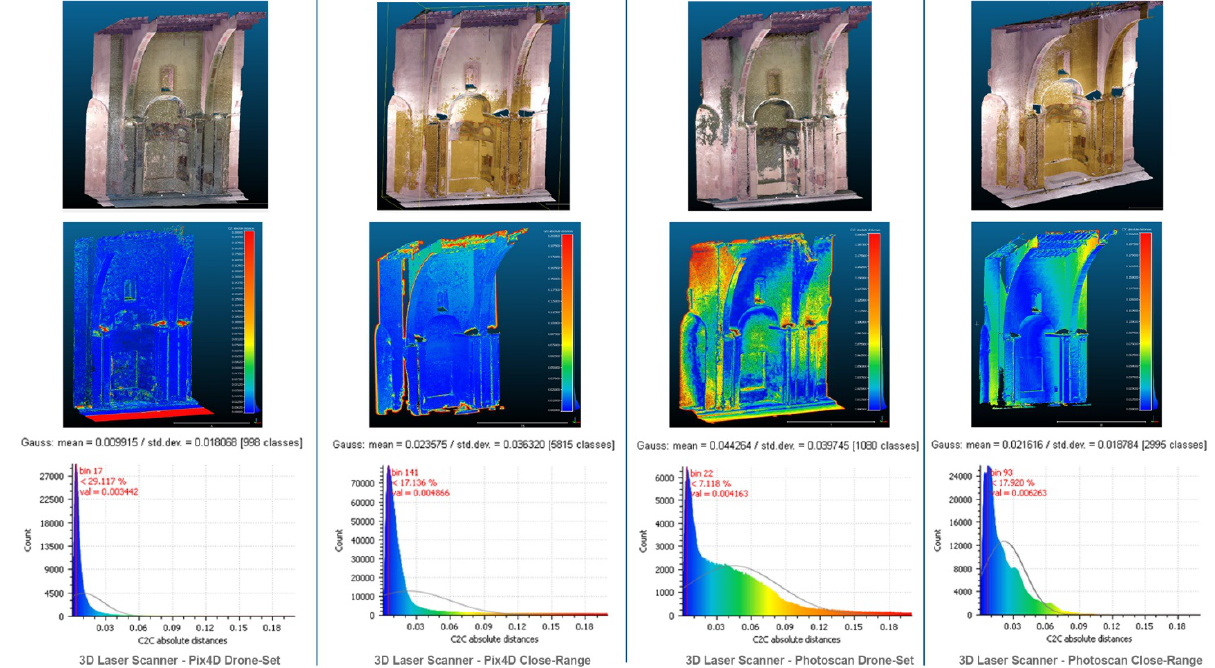
Figure 6. Comparison of different photogrammetric procedures with 3D laser scanning survey.